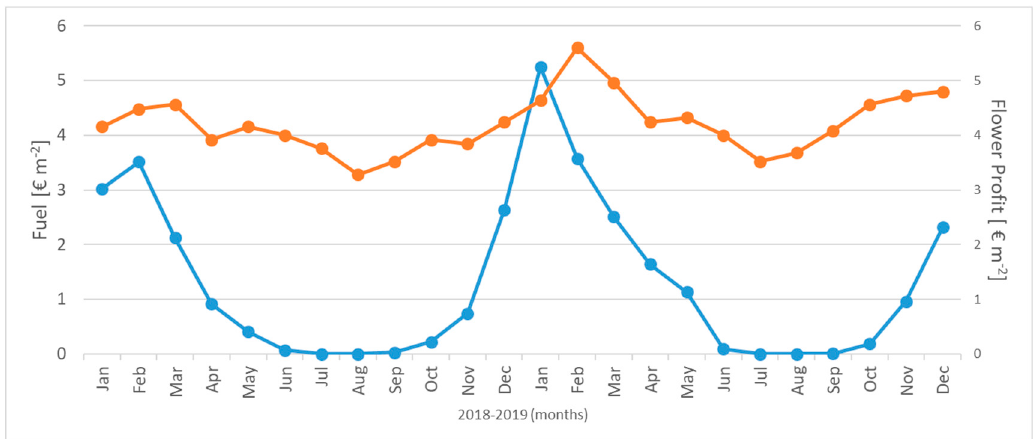
Figure 6. Fuel consumption (blue line) and flower profit (orange line) on a month basis of 2018 and 2019 calculated in a farm located in Sicily Region (Italy).